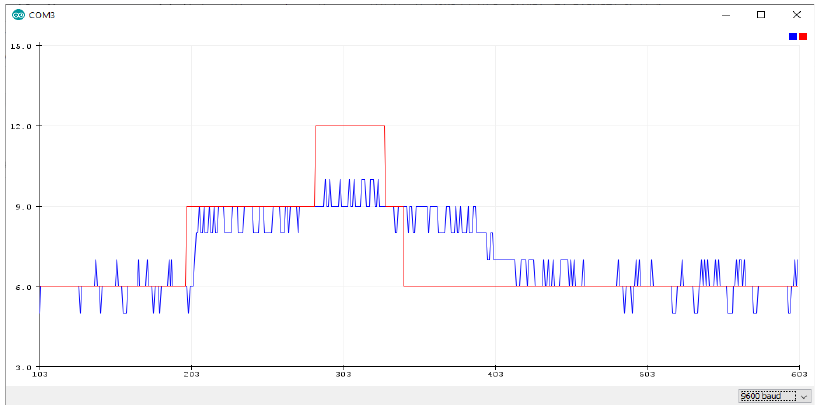
Figure 11. The dynamic behavior of the ventilation control system whose actual performance (blue line) is continuously trying to reach the user-provided target flow level (red line), as captured via the Serial Monitor tool.